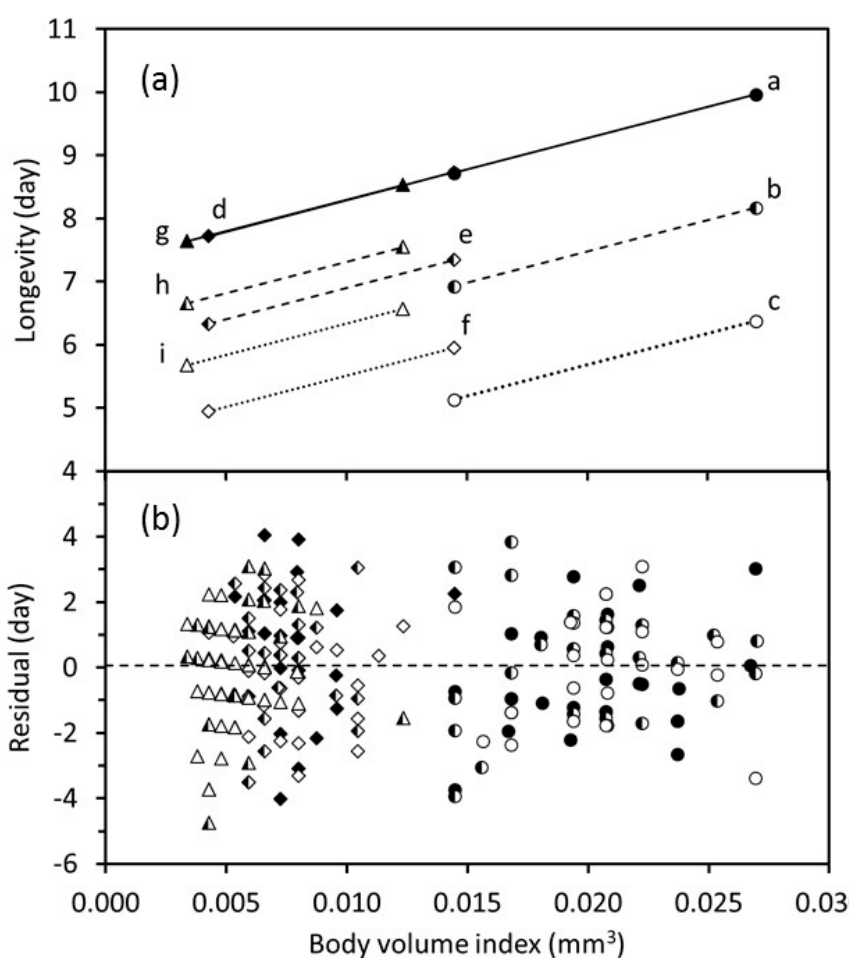
Figure 6. Relationship between body-volume index and adult longevity when Eretmocerus warrae developed at three constant temperatures and adults were subsequently held at one of three constant temperatures. ( a ) Fitted regression lines projected over the ranges of observed body-volume indices. Treatments shown by each line (immature temperature:adult temperature in °C) are: a, 20:20; b, 20:26; c, 20:32; d, 26:20; e, 26:26; f, 26:32; g, 32:20; h, 32:26; and i, 32:32. ( b ) Residuals from the regression analysis. Symbols indicate immature temperatures: 20— , 26— , 32— (cid:52) ; and adult temperatures: 20—filled symbols, 26—half-filled symbols, 32—open symbols ( p < 0.001).